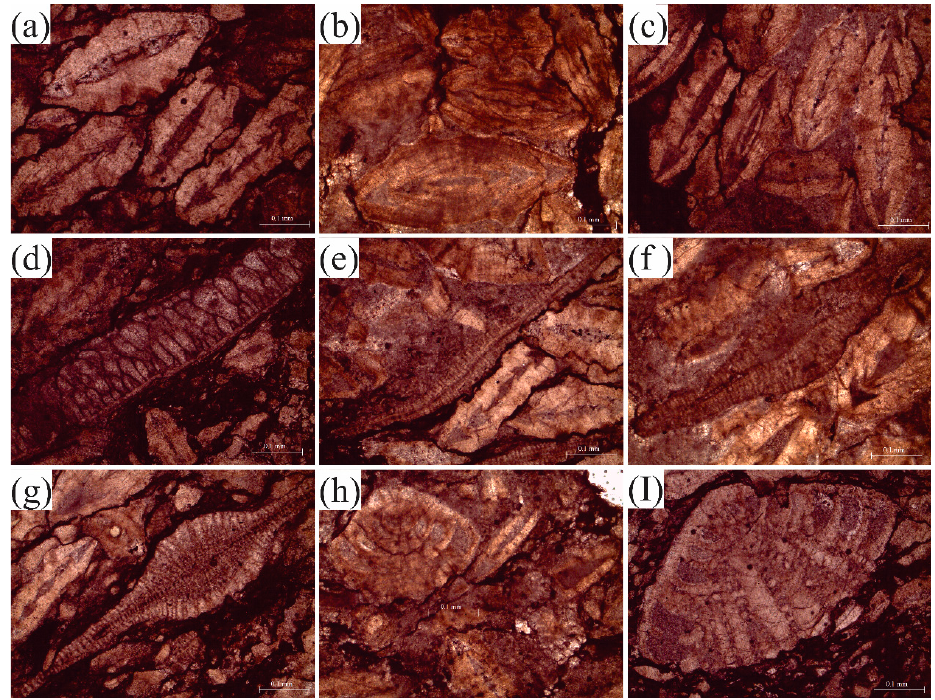
Figure 11. Photomicrographs showing ( a ) Assilina in the center to the right and Nummulites spp. on top; ( b , c ) Assilina spp.; ( d ) Coralline algae; ( e ) Discocyclina ranokotenesis in the center and Assilina spp. on the right; ( f , g ) Discocyclina zindaperensis in the center; and ( h , I ) Rotalia trochodiformis .